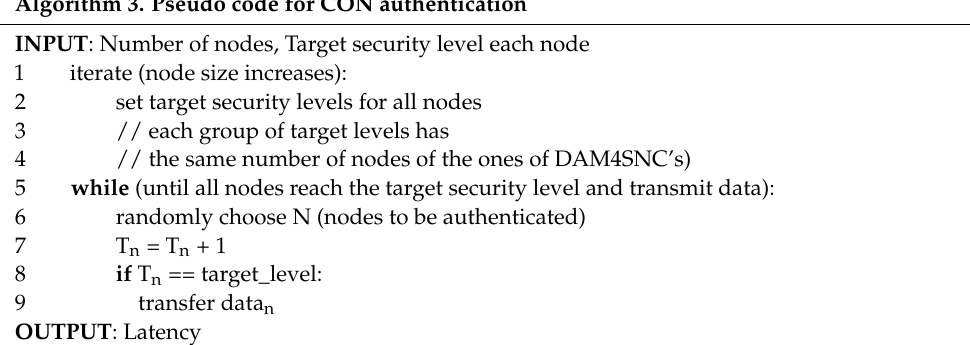
Algorithm 3. Pseudo code for CON